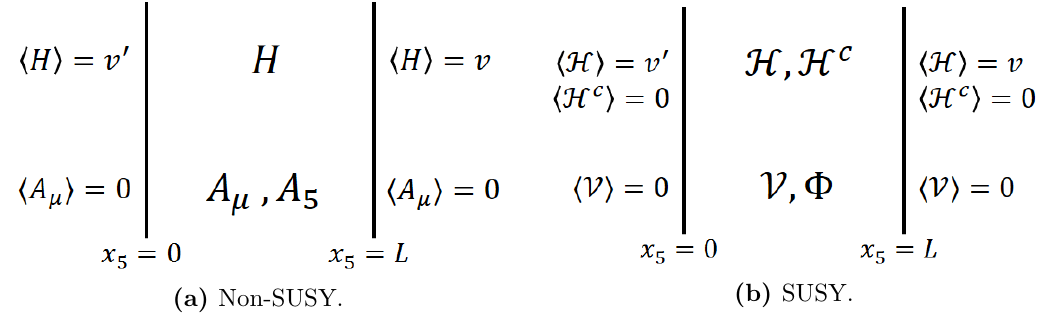
Figure 1 . 5D gauge (cid:12)eld and charged matter: (a) non-SUSY and (b) SUSY version. See text and table 1 for